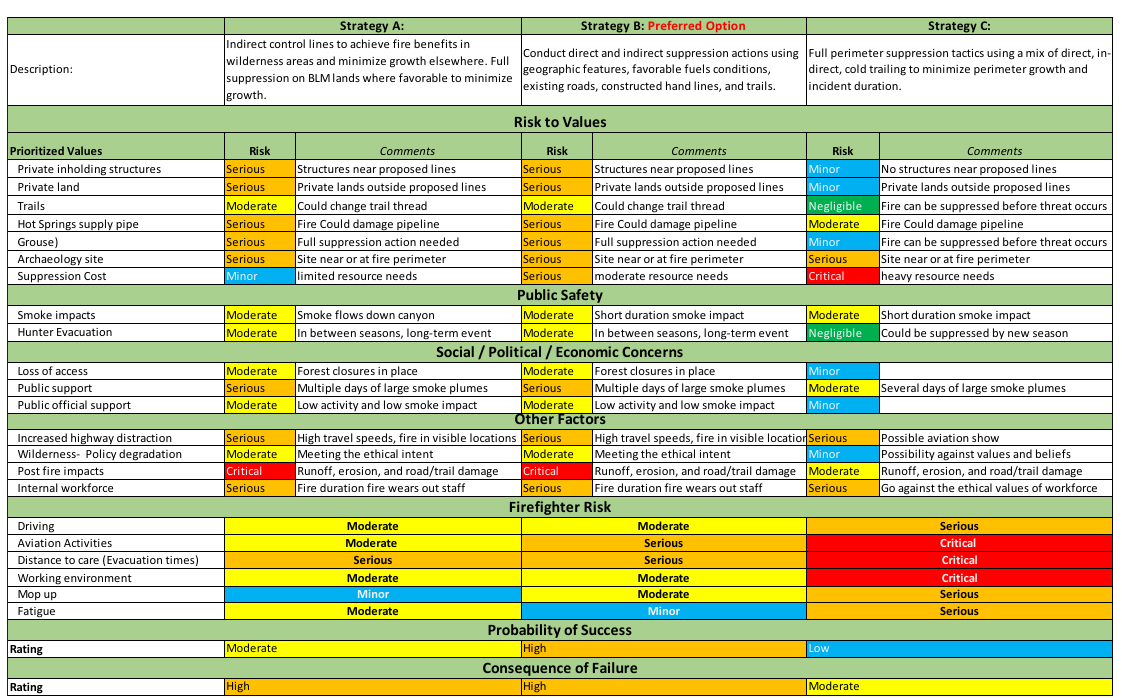
Figure 7. Tradeoff analysis from the Decker Fire on the Rio Grande National Forest, Colorado, USA. This figure is an edited version of the original document developed on 2 October 2019 to support strategic